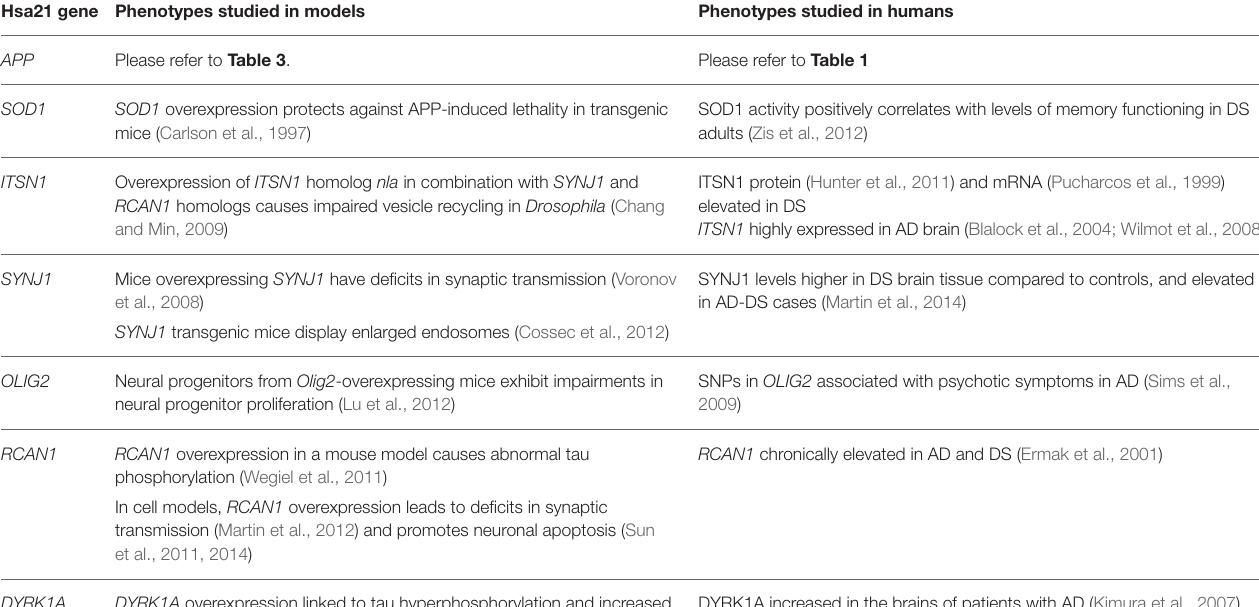
TABLE 5 | Single gene overexpression models from Hsa21, with relevance to AD phenotypes. Genes are listed in order from centromere to Hsa21q